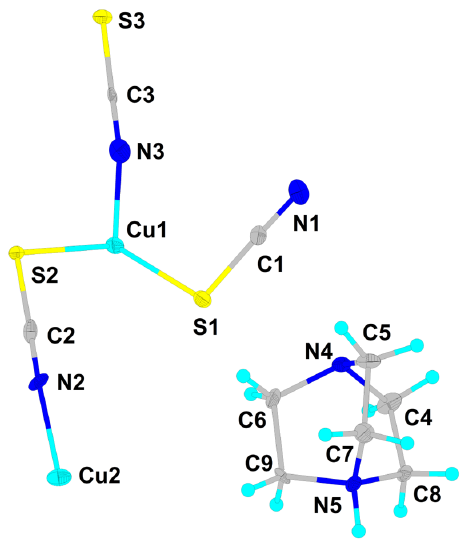
Figure 1. Crystallographically independent part of structure 1 . Thermal ellipsoids are drawn at the 50% probability level.